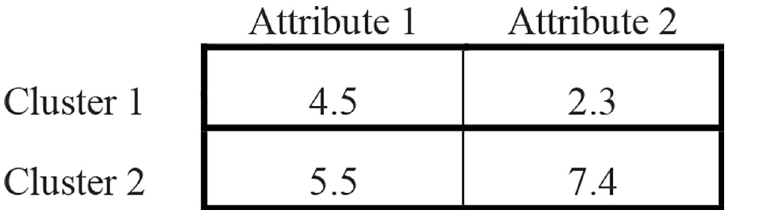
Fig 2. Cluster centroid-based representation of the